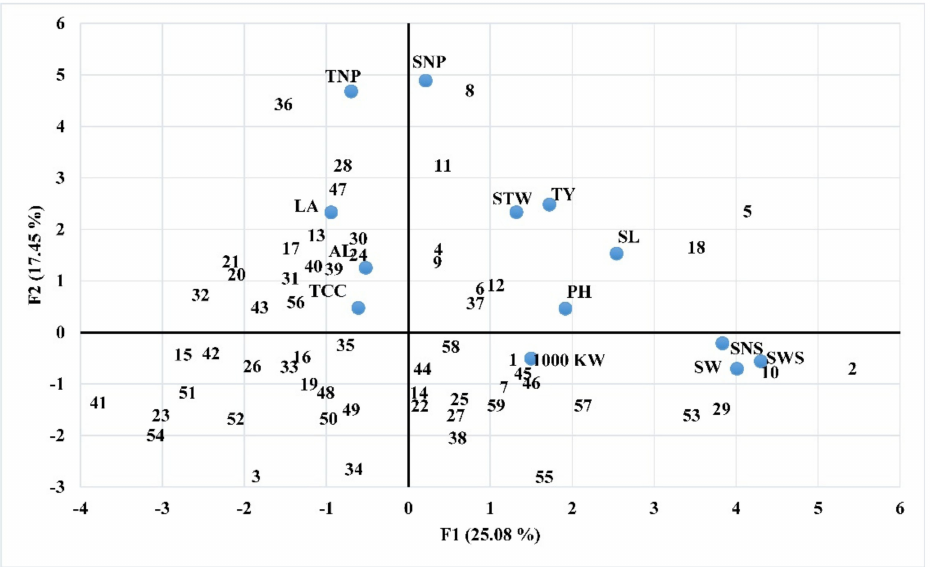
Figure 6. PCA plot depicts the distribution of barley accessions and investigated characteristics based on the percentage of responses under MOE application. PH: plant height, LA: leaf area, TCC: total chlorophyll content, TNP: number of the tillers per plant, SNP: number of the spikes per plant, SL: spike length, AL: awan length, SW: spike weight, SNS: number of seeds per spike, SWS: seed weight per spike, 1000-KW: 1000-kernel weight, TY: total yield per plot, STW: straw weight per plot. The numbers (1–59) represent the barley